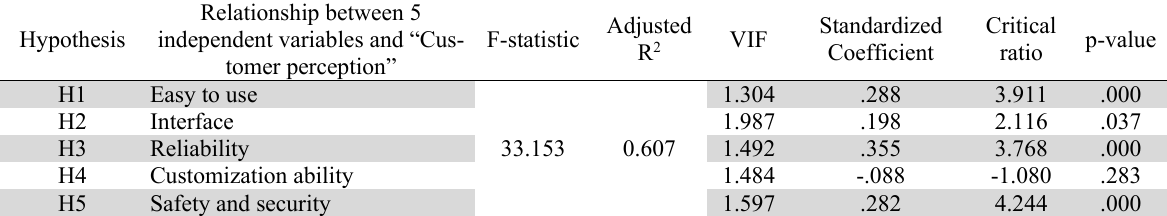
Regression Results